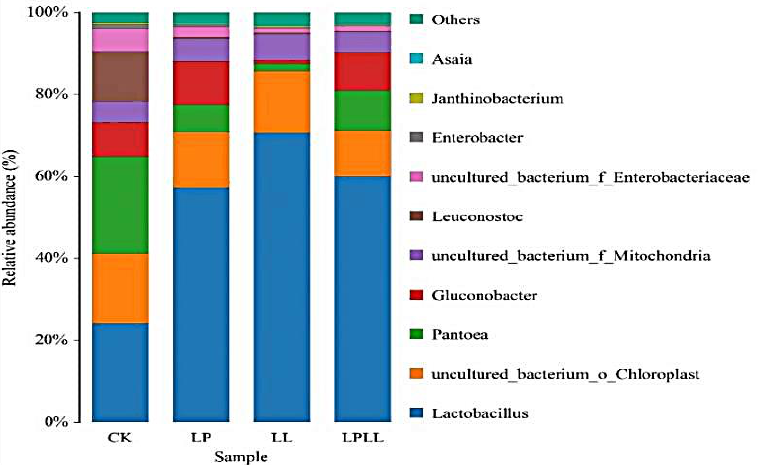
Figure 5 . UPGMA cluster analysis of bacteria relative abundance on Genus level . CK: fresh sugar- cane juice; LL: sugarcane juice with added HNK10; LP: sugarcane juice added with HNK21; LPLL: sugarcane juice treated with HNK10 + HNK21 was